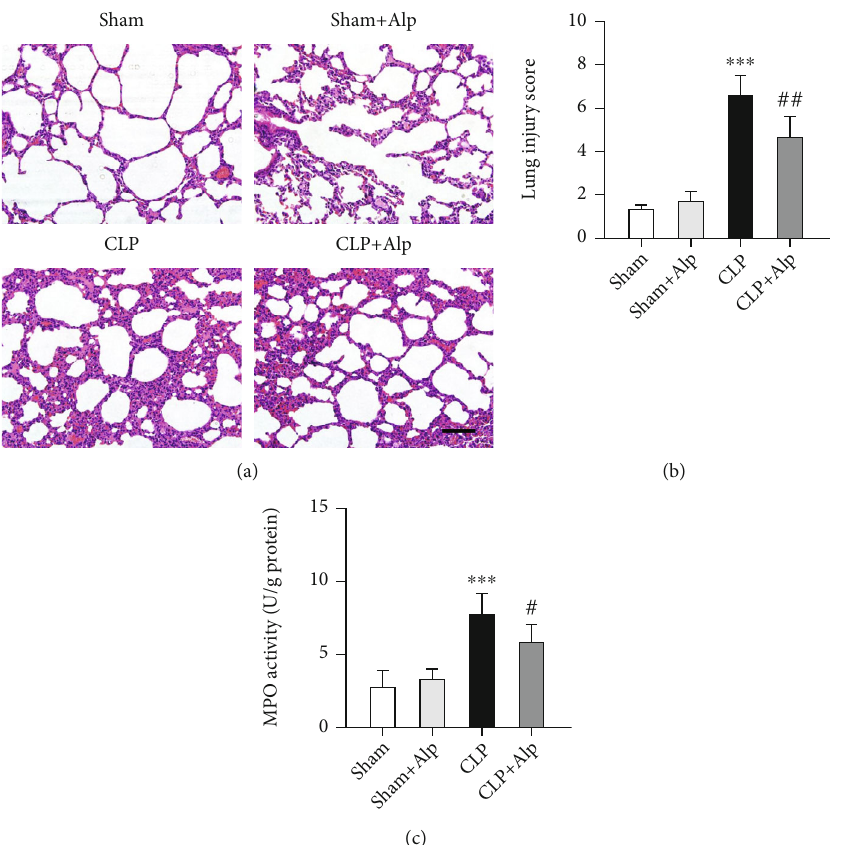
Figure 6: E ff ects of alpinetin on lung injury and MPO activity. (a) Representative images of H&E-stained lung tissues from di ff erent groups. (b) Lung injury score. (c) MPO activity was analyzed using MPO Assay Kits. The scale bar is 50 μ m. Sham ( n = 8 ), sham+Alp ( n = 8 ), CLP ( n = 6 ), and CLP+Alp ( n = 8 ). Data are shown as mean ± SD . ∗∗∗ p < 0 : 001 , CLP vs. sham; ## p < 0 : 01 , CLP-Alp vs.